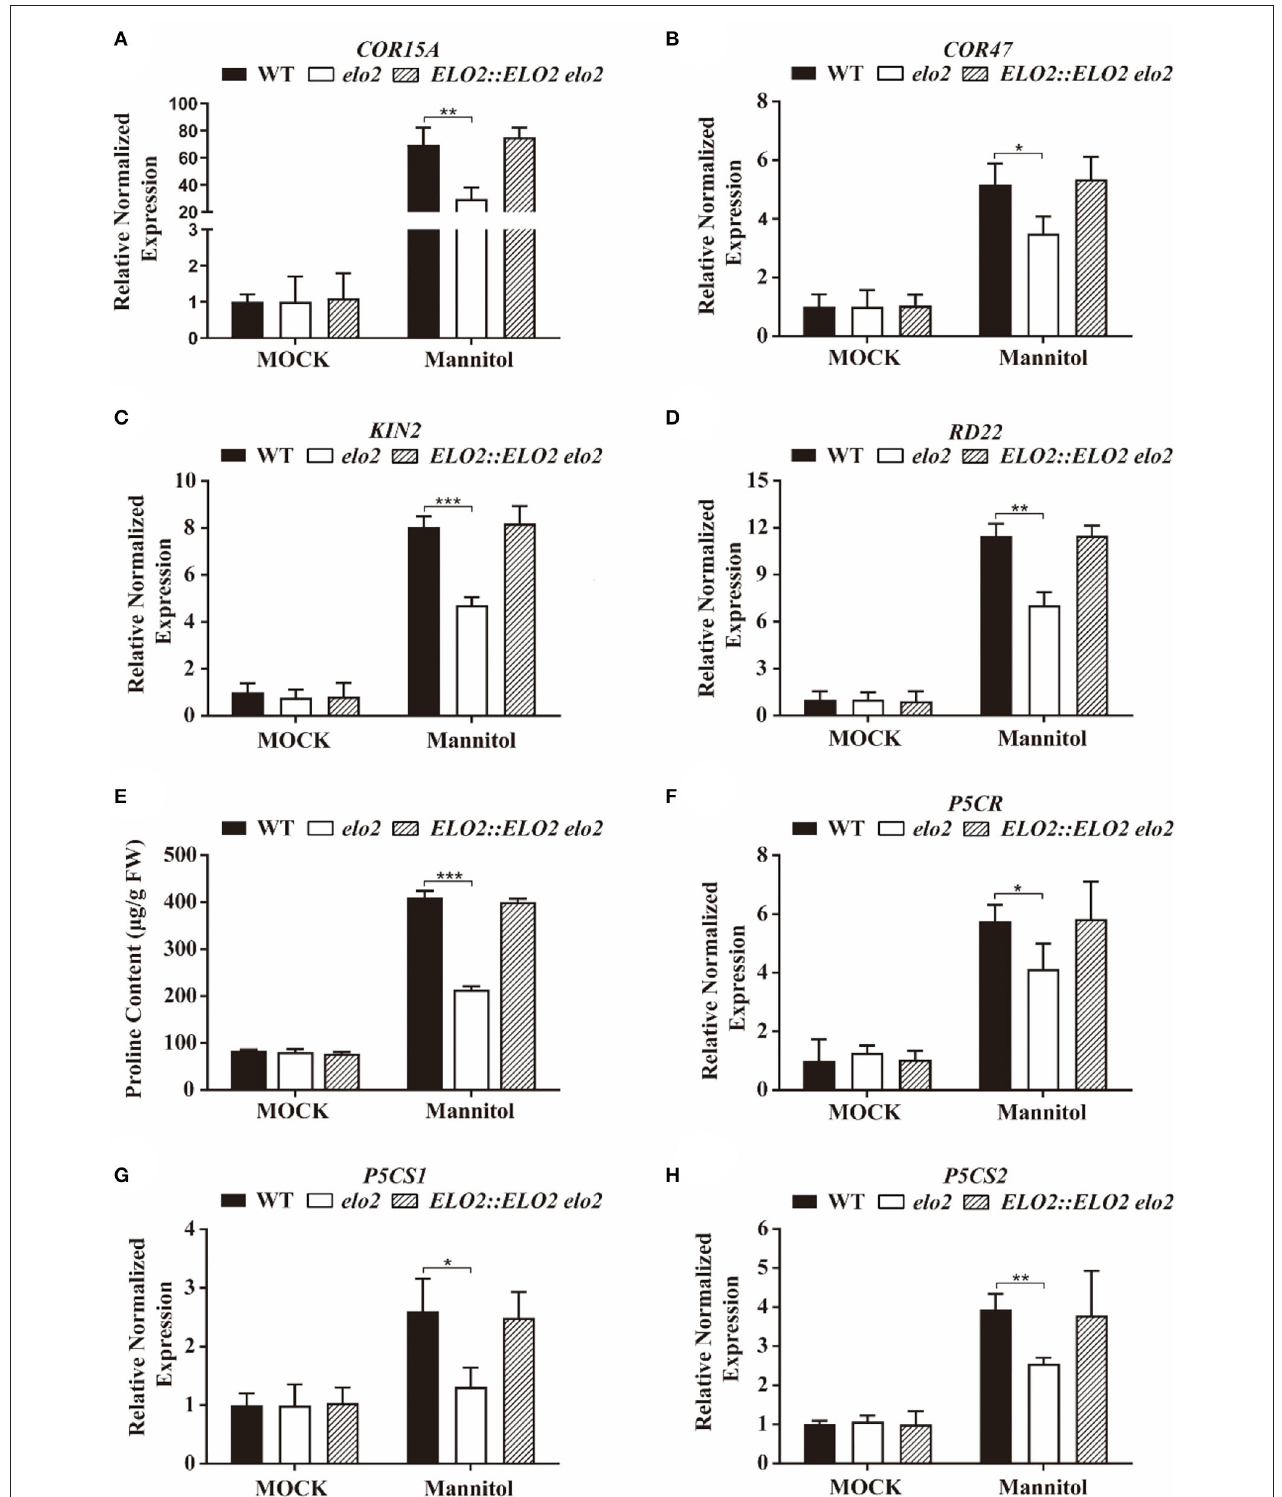
FIGURE 4 | ELO2 is involved in the expression of stress-responsive genes and proline synthesis in plant osmotic stress response. (A–D) Relative normalized expression of COR15A (A) , COR47 (B) , KIN2 (C) , and RD22 (D) in 5-day-old WT, elo2 , and ELO2::ELO2 elo2 seedlings under 250mM mannitol treatment for 12h or not. (E–H) Proline content (E) and relative normalized expression of proline biosynthetic genes, P5CR (F) , P5CS1 (G) , P5CS2 (H) in mannitol-treated and untreated elo2 , and ELO2::ELO2 elo2 . Data shown are means ± SD of three independent biological replicates. Asterisks indicate significant differences from the osmotic stressed wild-type plant (Student’s t -test): * P < 0.05; ** P < 0.01; *** P < 0.001.